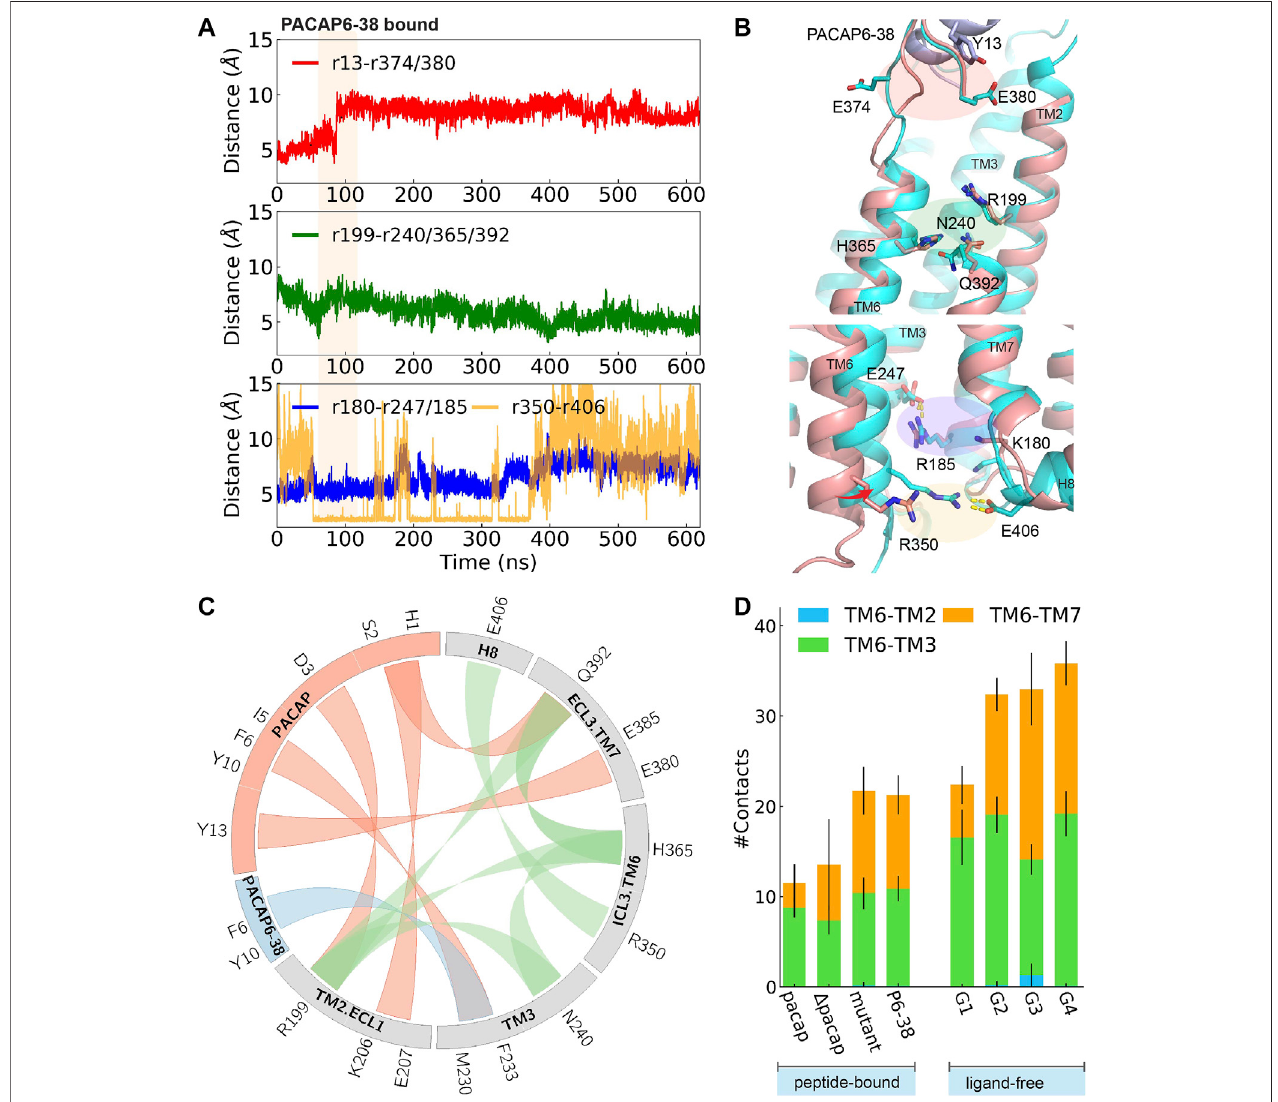
FIGURE4| Timeevolutionofaveragedistanceorpairdistanceofkeycharged/polarresidueslocatingatextracellularside,middletransmembrane,andintracellular side of PAC1null binding PACAP6-38, which are illustrated in (B) accordingly. Adaptive tempering period is in light orange strip background. (B) Final snapshot of PACAP6-38boundPAC1null(cyan)superposedonPACAP-activatedPAC1nullstructure(red),inwhichaninwardshiftingofTM6wasobserved. (C) Wheelplotofmajor polar and hydrophobic interactions in the N-terminus of PACAP bound PAC1null (in red), N-terminus of PACAP6-38 bound PAC1null (in blue), and residue interactions within ligand-free PAC1null (in green). (D) Stack histogram of number of contacts between the intracellular half of TM6 (residues 344 – 360) and TM2, TM3, and TM7 in PAC1null receptor with: PACAP, PACAP deleted ( Δ PACAP), PACAP6-38 (P6-38), and PACAP mutant (G4A, I5V, S9N, S11T, Y13L). Collections of the